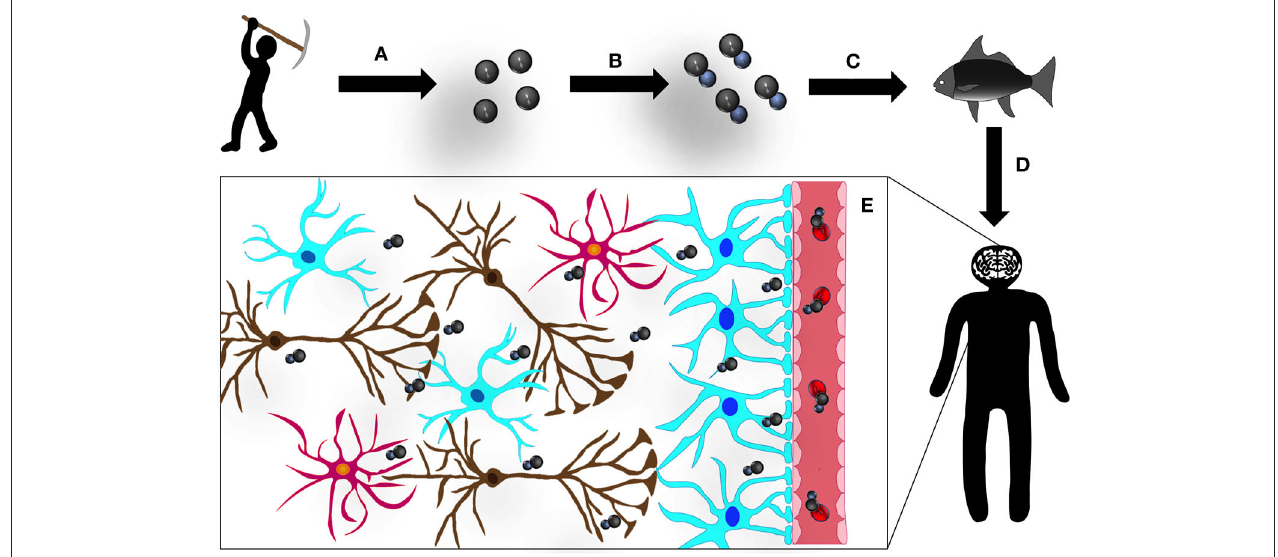
FIGURE 1 | Mercury (Hg): the road to the CNS: (A) small-scale and artisanal gold mining releases Hg to the environment, contaminating soil, lakes, and rivers; (B) Hg is methylated by bacteria in aquatic sediments converting to its organic form, methylmercury (MeHg); (C) this organic MeHg bioaccumulates in predatory fish, undergoing a process of biomagnification and (D) enters the human organism via contaminated seafood consumption; and (E) in the human blood stream, MeHg binds to β -chain hemoglobin in erythrocytes and forms a complex with the aminoacid cystein (complex similar to methionine, MeHg-S-Cys), which can be transported by L-aminoacid transporter (LAT-1) and easily crosses the BBB. Once in the CNS, MeHg disseminates, intoxicating all cell types and